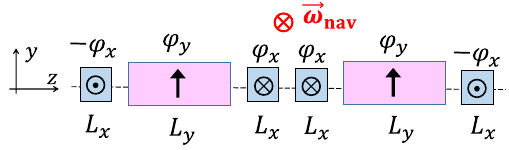
Fig. 5 SN scheme based on radial-field dipoles